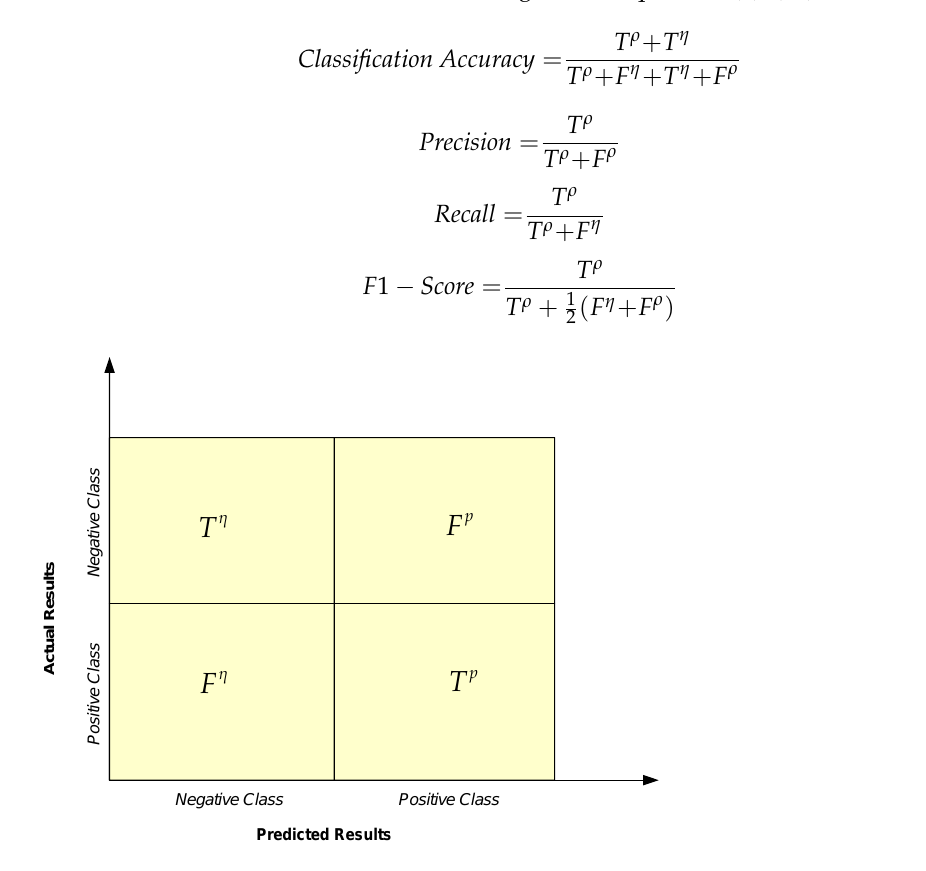
Figure 6. Confusion matrix plot.